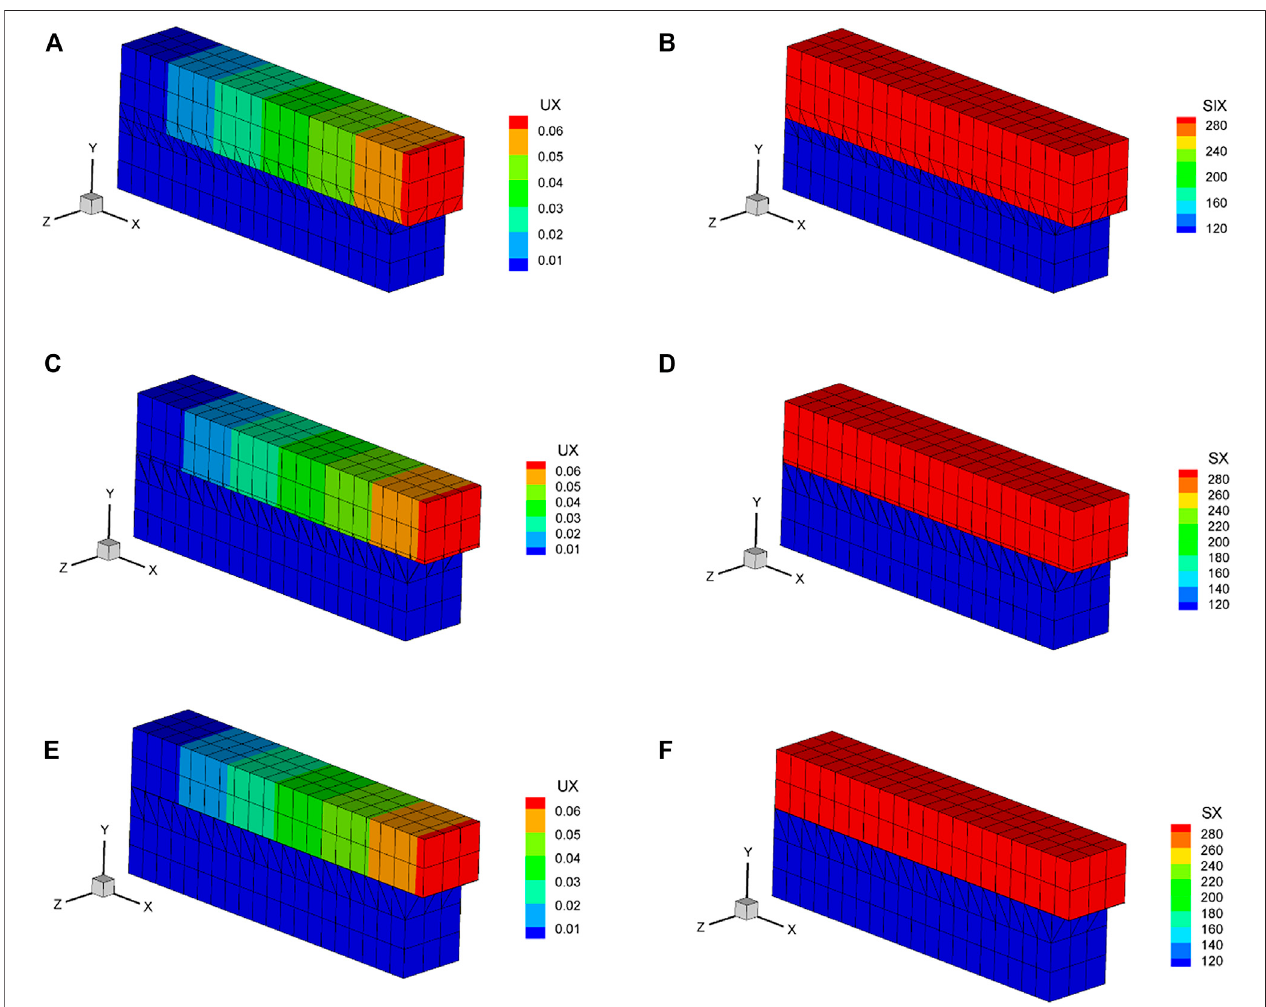
FIGURE14| Displacementandstressresultsforstructuredmesh. (A) x -directiondisplacementof R (cid:2) 0.5(Unit:m); (B) x -directionstressof R (cid:2) 0.5(Unit:MPa); (C) x -direction displacement of R (cid:2) 0.1 (Unit: m); (D) x -direction stress of R (cid:2) 0.1 (Unit: MPa); (E) x -direction displacement of R (cid:2) 0.01 (Unit: m); (F) x -direction stress of R (cid:2) 0.01 (Unit: